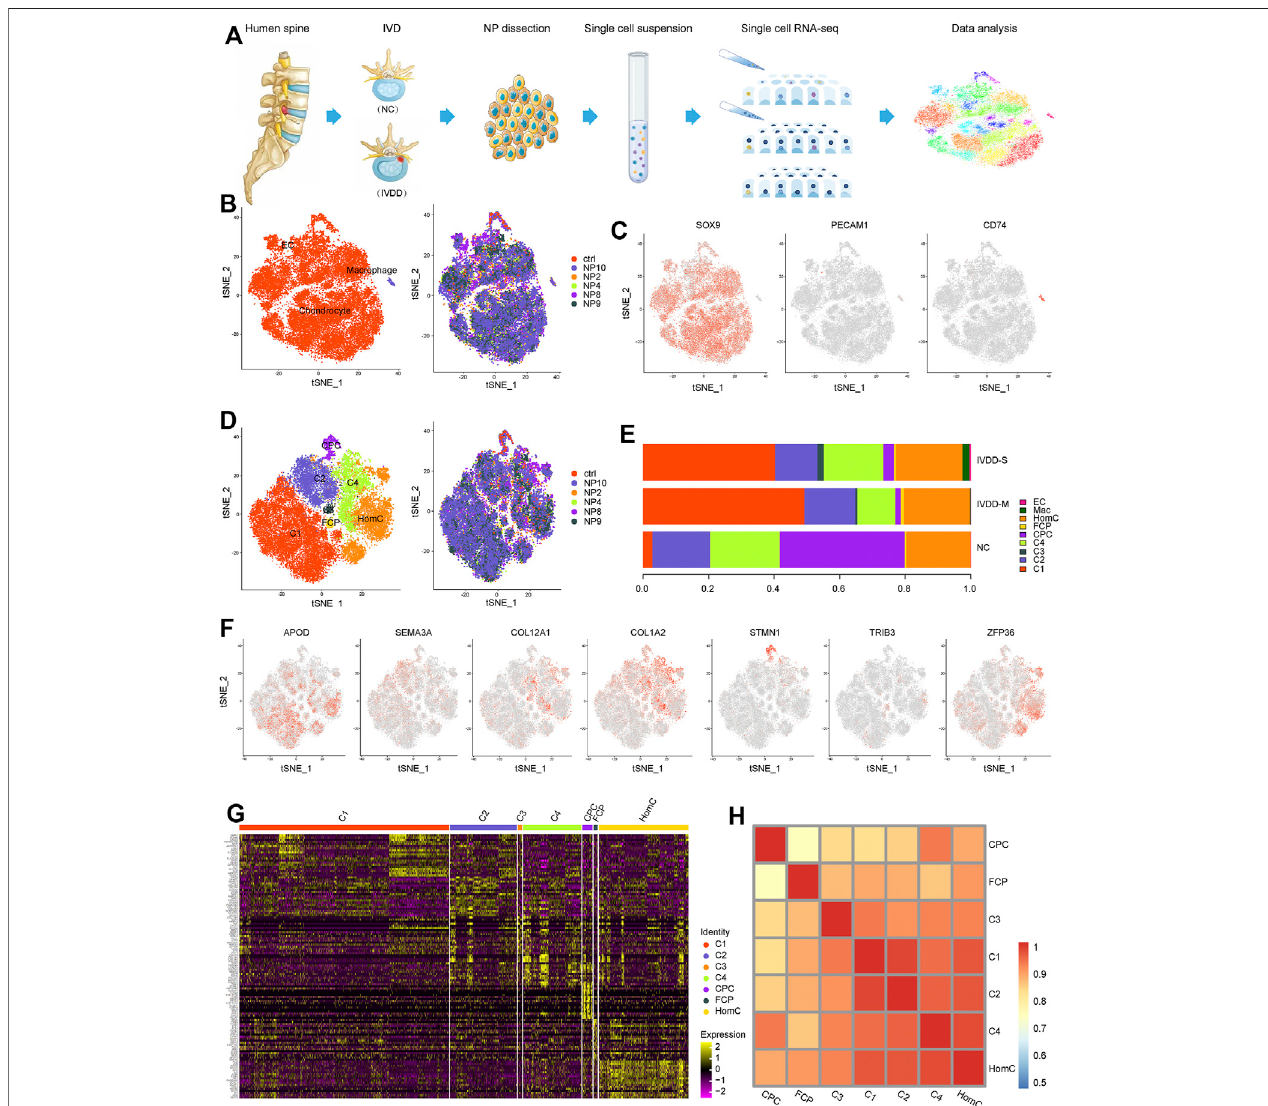
FIGURE1| Single-cellatlasofhealthyanddegenerativeNPsamples. (A) Schematicdiagramofsamplesourceandexperimentalwork fl ow. (B) t-SNEofthe30,300 cells pro fi led three main cell types (left) and six samples (right) distribution. (C) t-SNE plots showing the expression of marker genes for chondrocyte, macrophage, and ECde fi nedaboveeachpanel. (D) t-SNEofthechondrocytespro fi ledsevensubclusters(left)andsixsamples(right)distribution. (E) Barplotsrepresentedtheproportion ofthedistinctcellclustersinNPfromNC,IVDD-M,andIVDD-S. (F) t-SNEplotsshowingtheexpressionofmarkergenesforsevenchondrocytesubclustersde fi ned above each panel. (G) Heatmap oftop20DEGsforsevenchondrocytesubclusters; each column representsacellcluster,and each rowrepresentsaDEGforacluster. (H) Heatmap showing pairwise Pearson correlations in each chondrocyte subcluster. NP, nucleus pulposus; t-SNE, t-distributed stochastic neighbor embedding; EC, endothelial cells; CPC, cartilage progenitor cells; FCP, fi brochondrocyte progenitors; HomC, homeostatic chondrocytes; DEGs, differentially expressed genes.